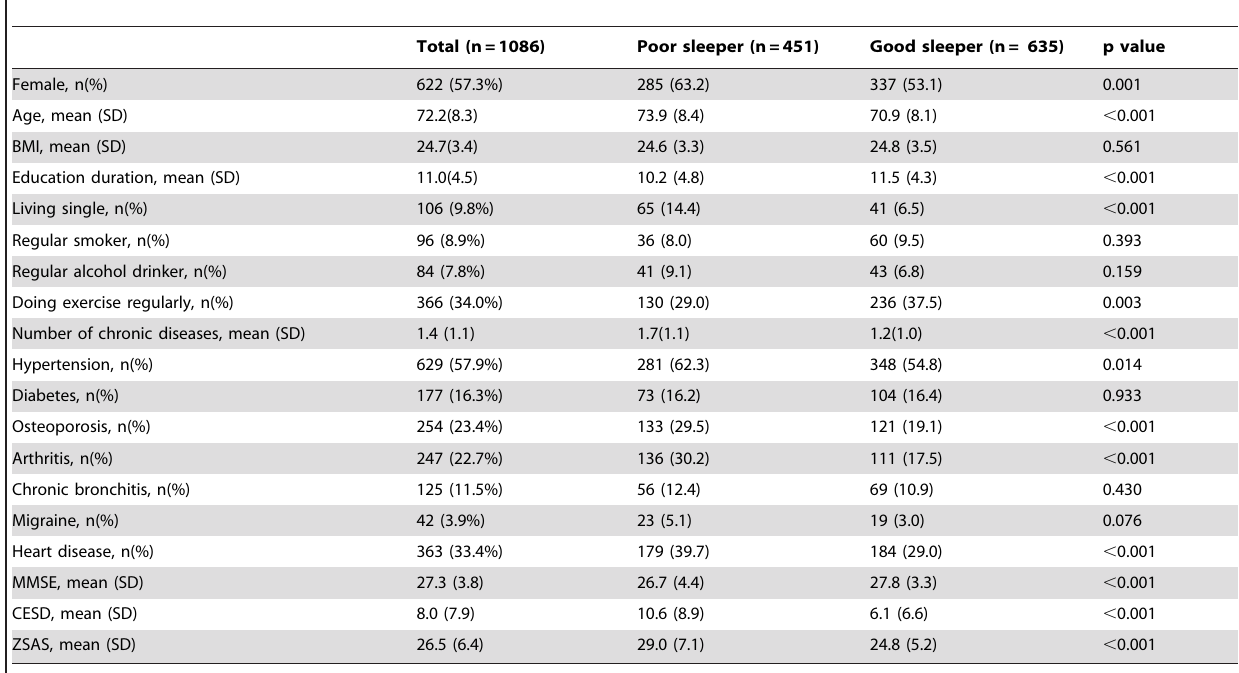
Table 1. Socio-demographic characteristics and clinical disorders between good sleeper and poor